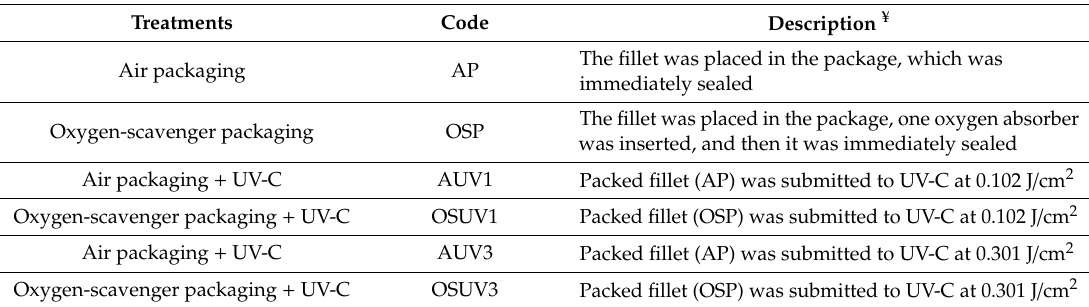
Table 1. Treatments applied in rainbow trout ( Oncorhynchus mykiss ) fillets stored at 4 ± 1 ◦ C for 9 days. Treatments Code Description